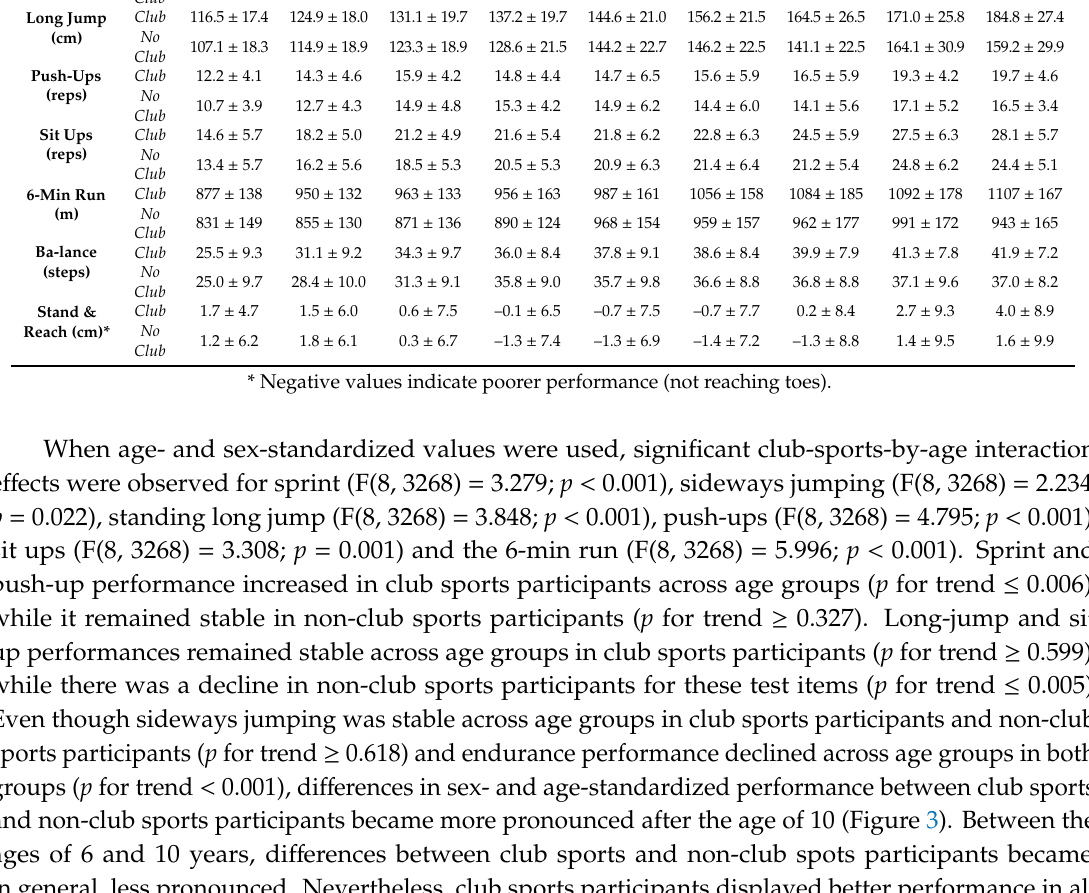
Table 2. Physical fitness in club sports participants and non-club sports participants by age group. Values are mean ± SD.